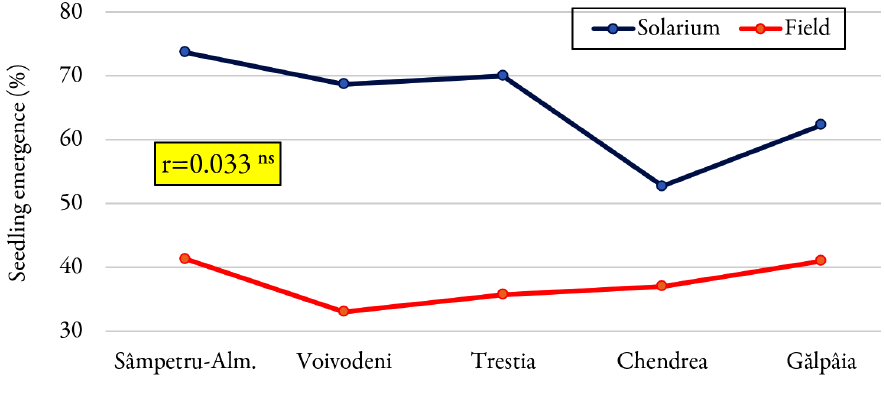
Figure 5. Coefficient of correlation between seedlings’ emergence (as a percentage of total sown seeds belonging to plus trees selected in five stands) in two different conditions: grown in the solarium and the